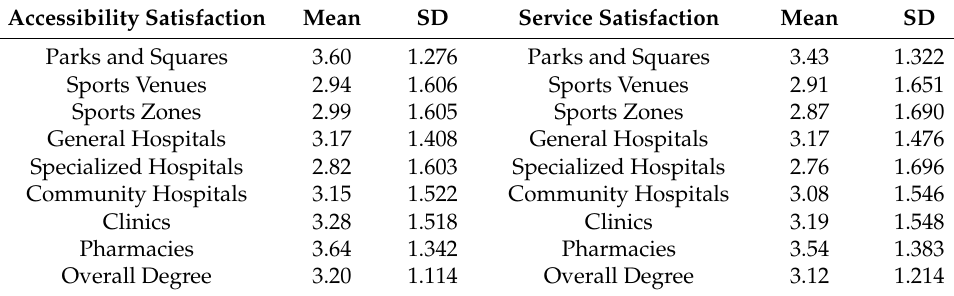
Table 4. Descriptive statistics of the resident satisfaction scores.